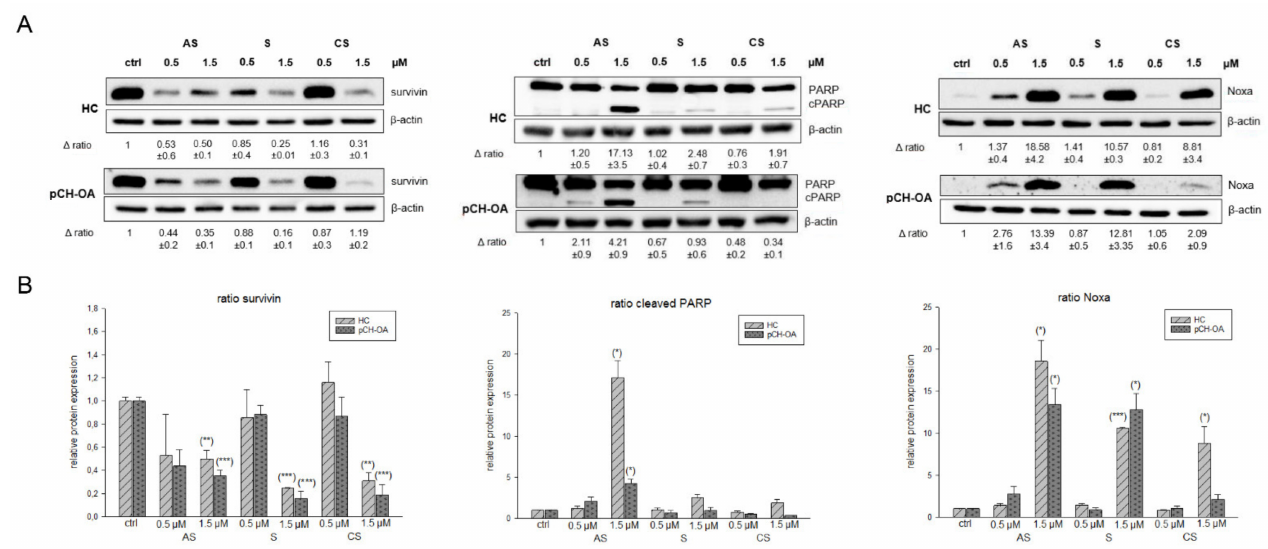
Figure 6. Influence on apoptotic targets. ( A ) Relative protein expression analysis of survivin, Noxa, and cleaved PARP after treatment with 0.5 µ M and 1.5 µ M acetylshikonin (AS), shikonin (S), and cyclopropylshikonin (CS) for 24 h in HC and IL1 β -stimulated pCH-OA cells. Untreated control cells (ctrl) served as reference value and β -actin as loading control (mean ± SD, n = 3). ( B ) Shows the densiometric evaluation of all experiments in HC (light grey striped) and pCH-OA (dark grey dotted) cells. Statistical significances are defined as follows: * p < 0.05; ** p < 0.01; *** p <